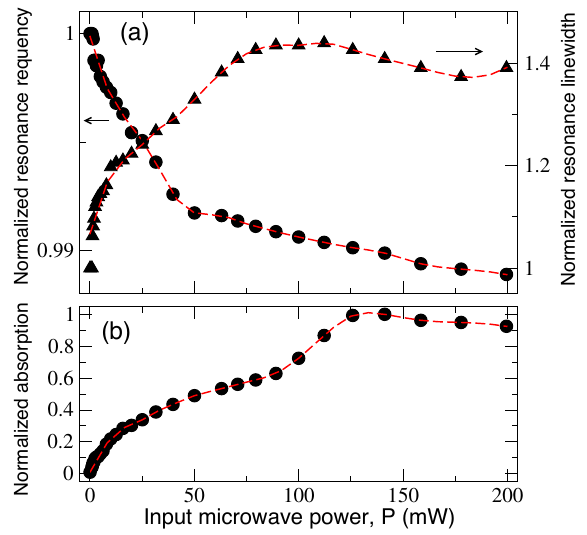
Figure 5. Experimental microwave power dependence for the Néel DW resonance. (a) Reduced DW resonance frequency and reduced DW resonance linewidth as a function of the input mi- crowave power P. (b) Reduced microwave power absorption at resonance as a function of P. The normalization rules are the same as in Fig. 4. The dashed lines are guides to the eyes.